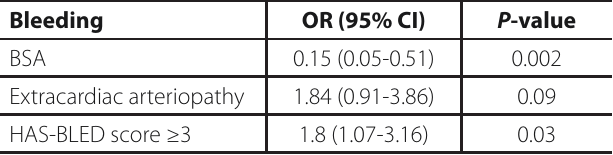
Table 2. Multivariable logistic regression for factors affecting bleeding.